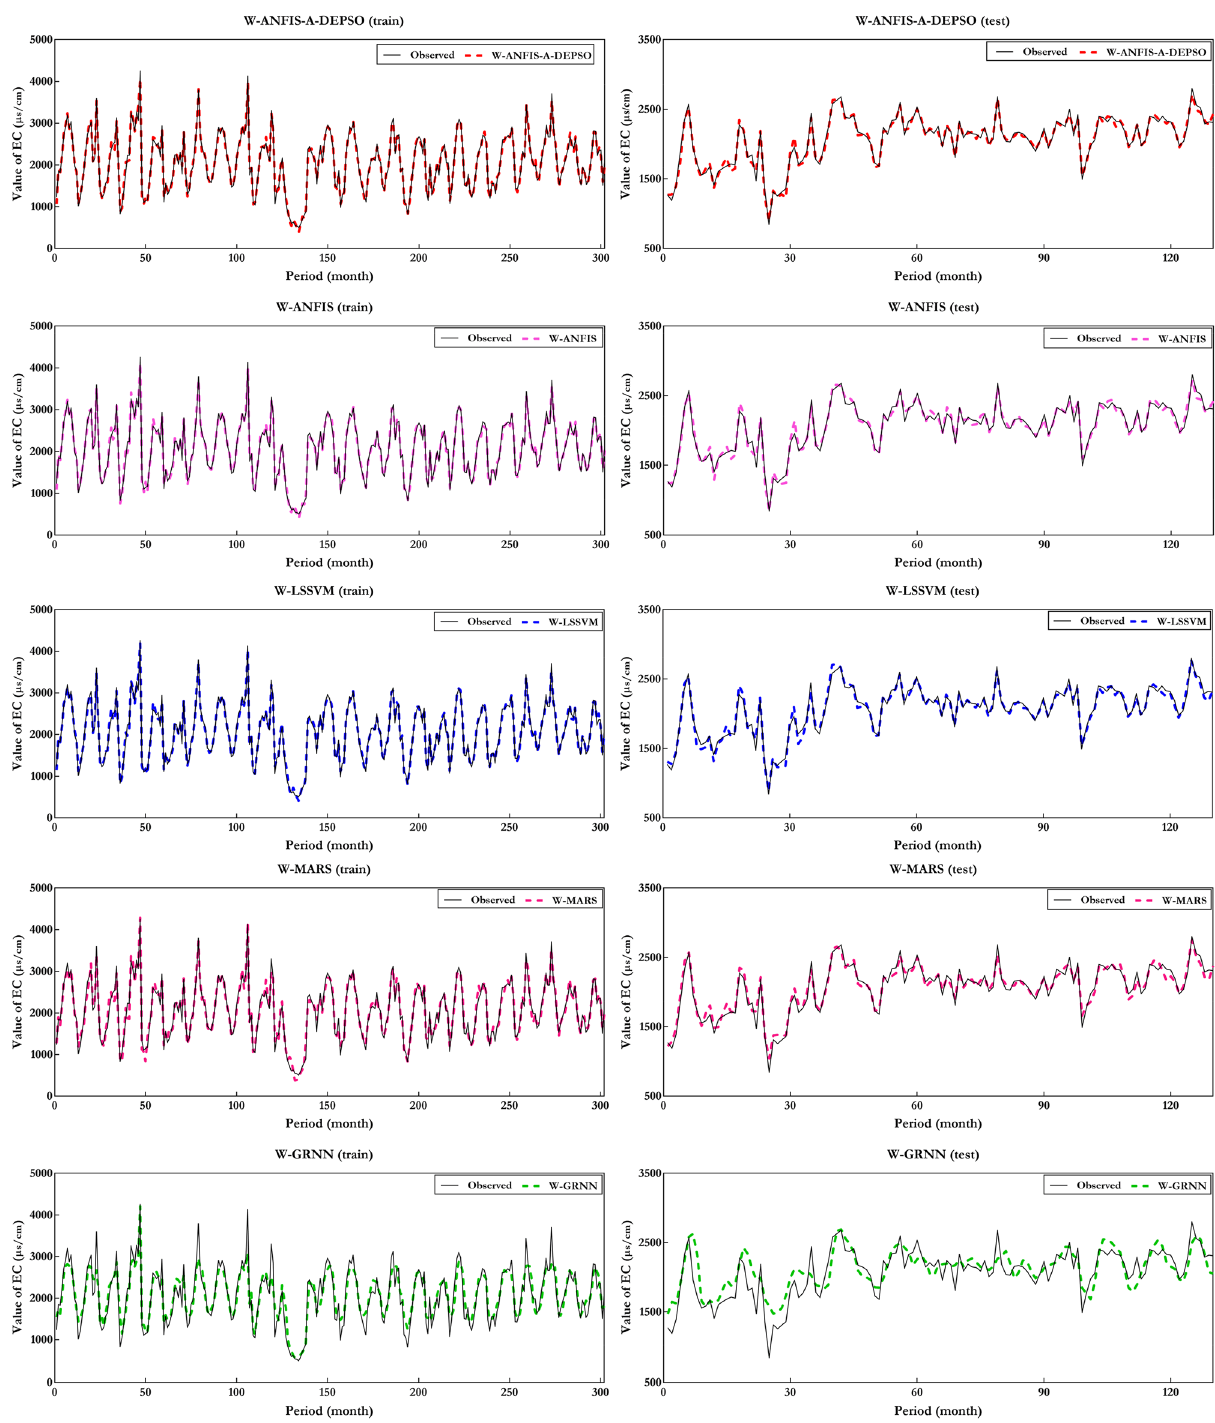
Figure 15. Compare the physical trend of the best performance of all ML